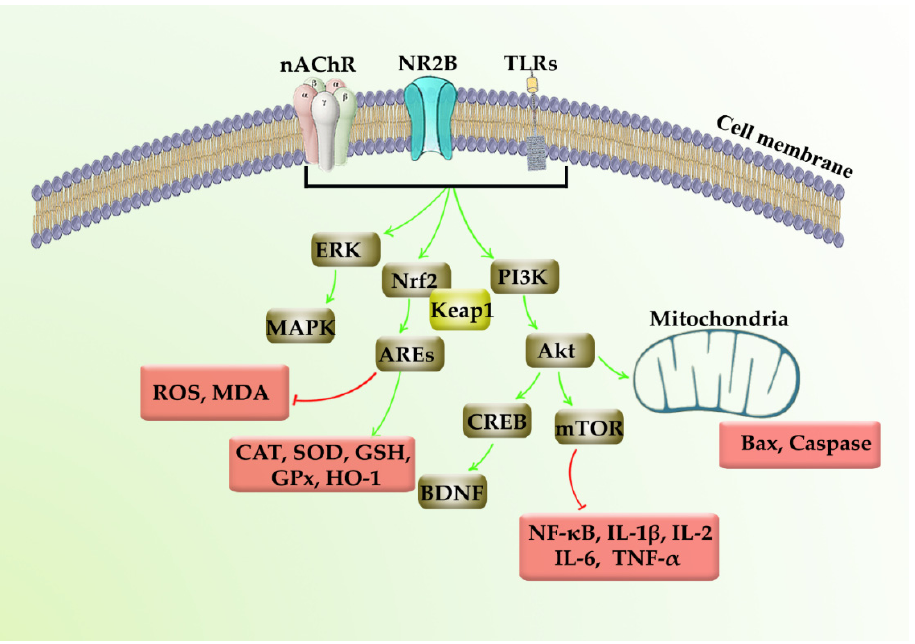
Figure 4. Neuroprotective mechanisms of polydatin.